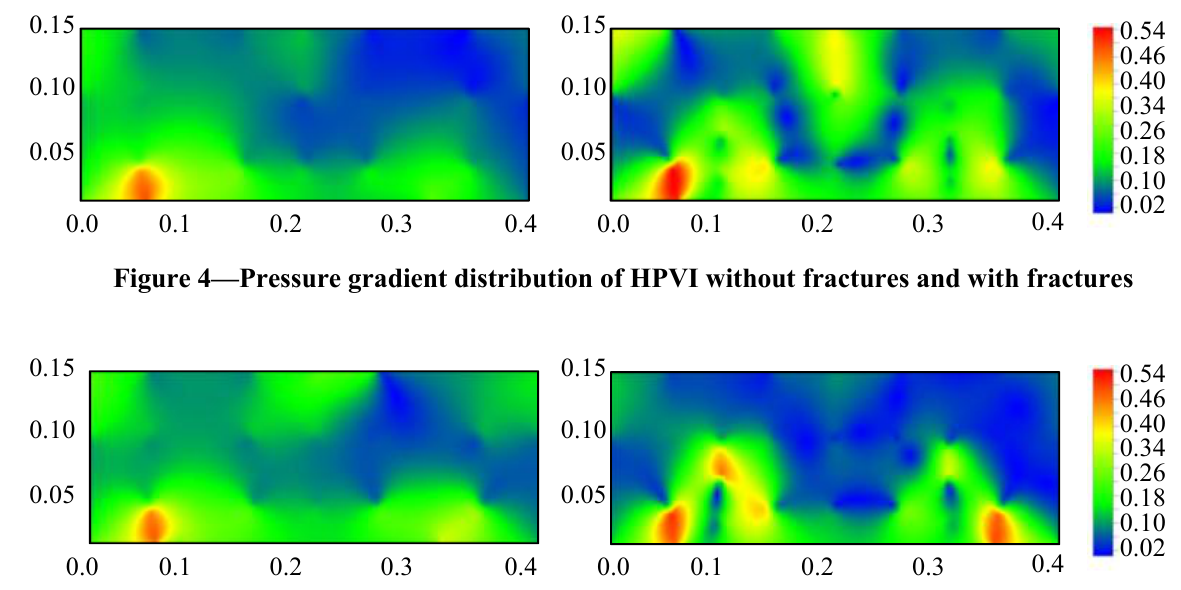
Figure 5—Pressure gradient distribution of HIVP without fractures and with fractures